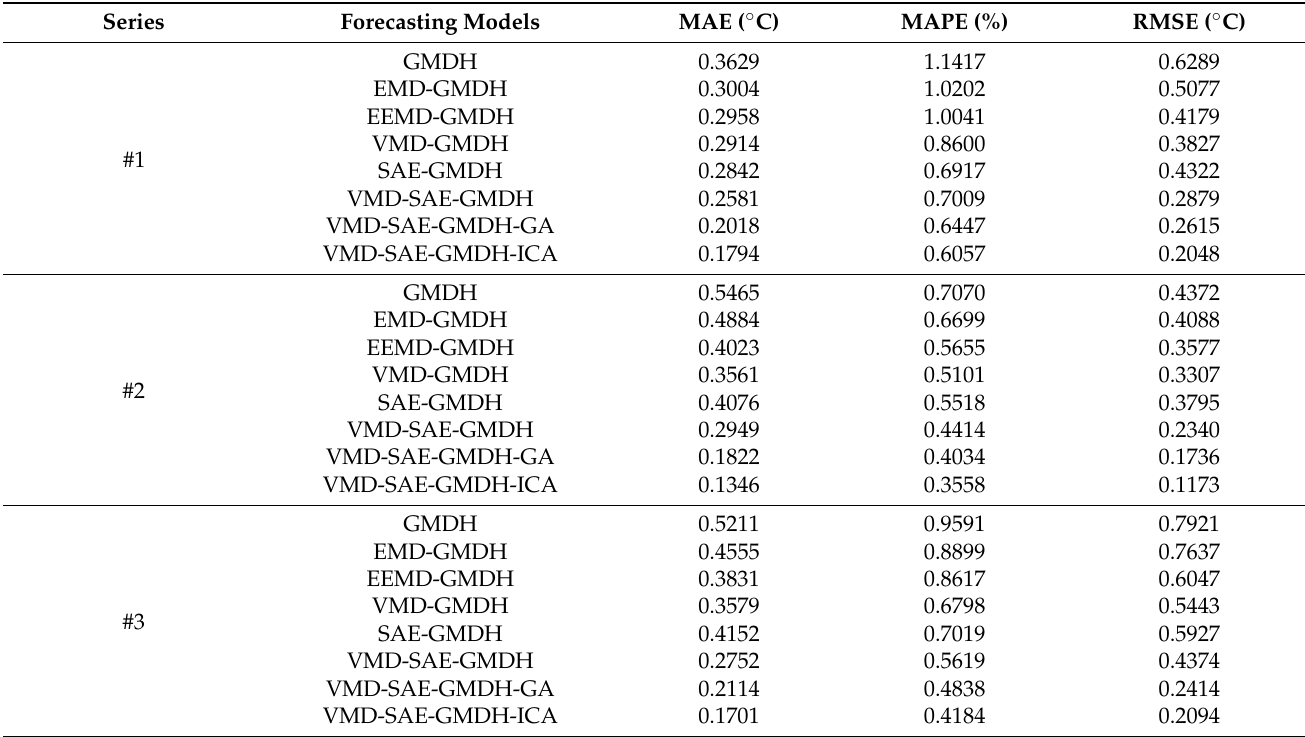
Table 5. The error evaluation results of different methods.